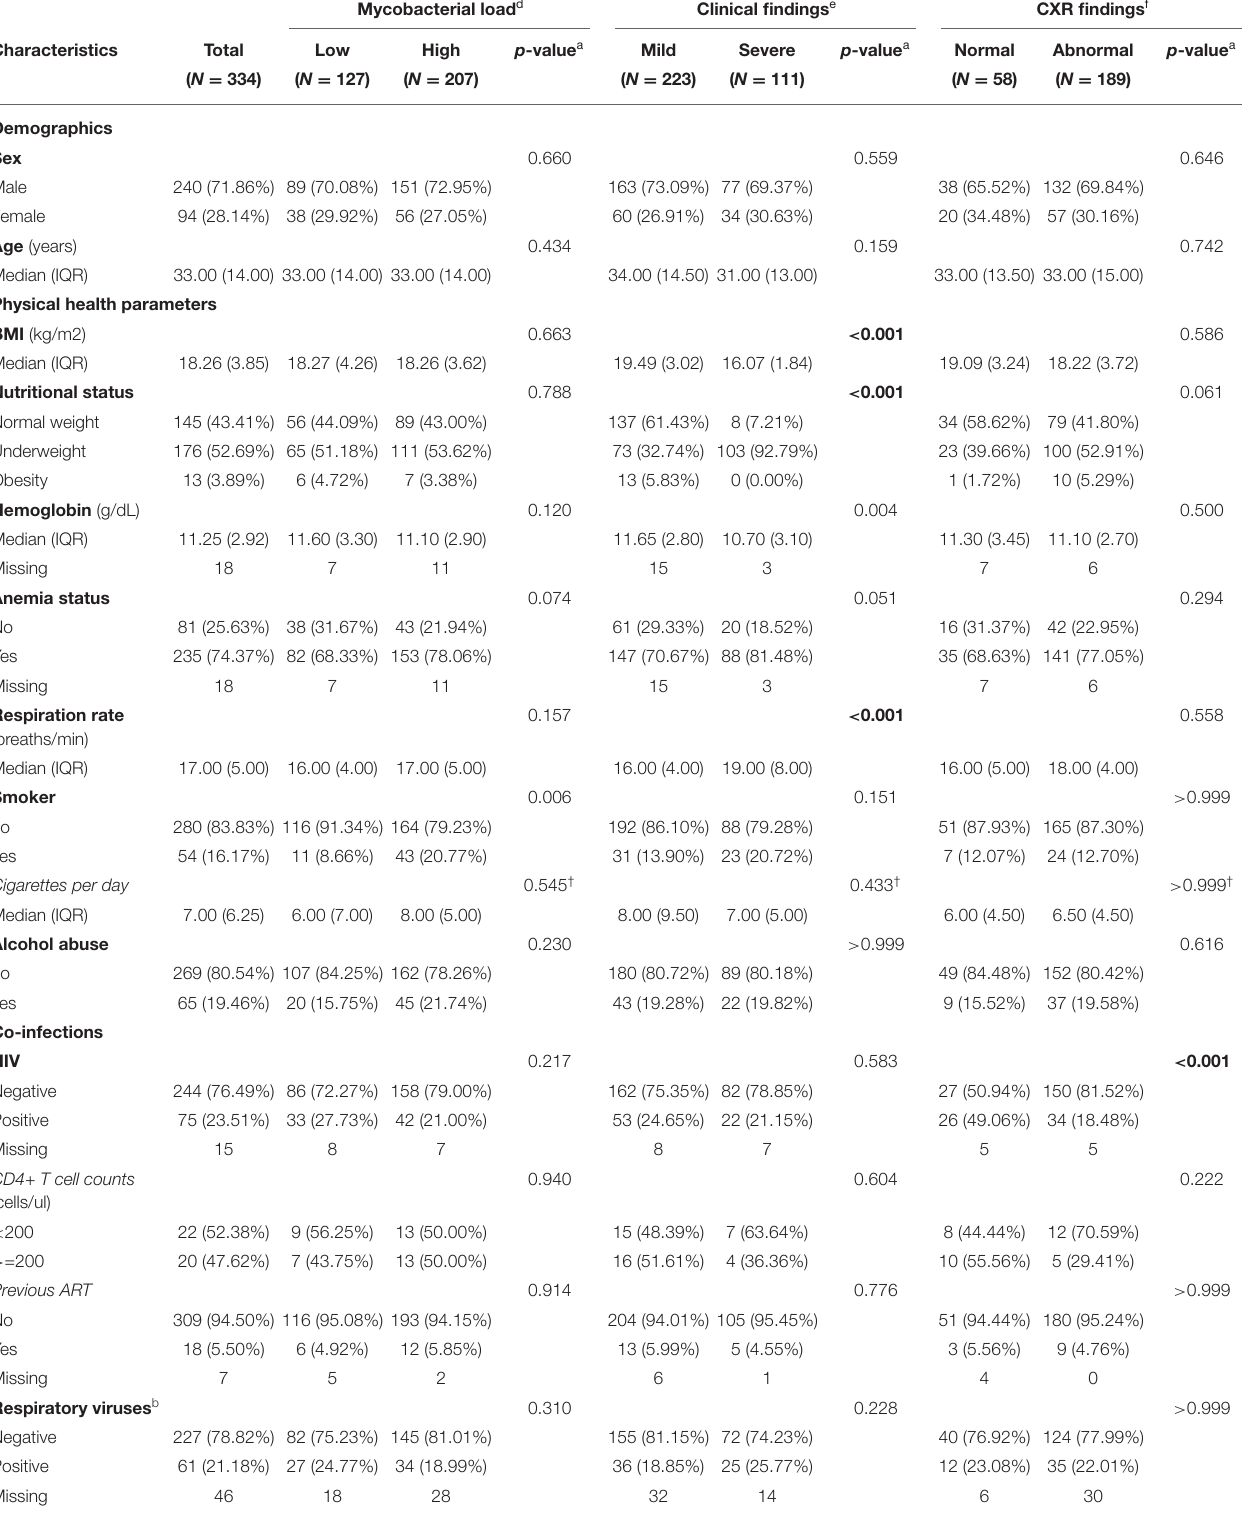
TABLE 1 | Characteristics of TB patients and associations with disease